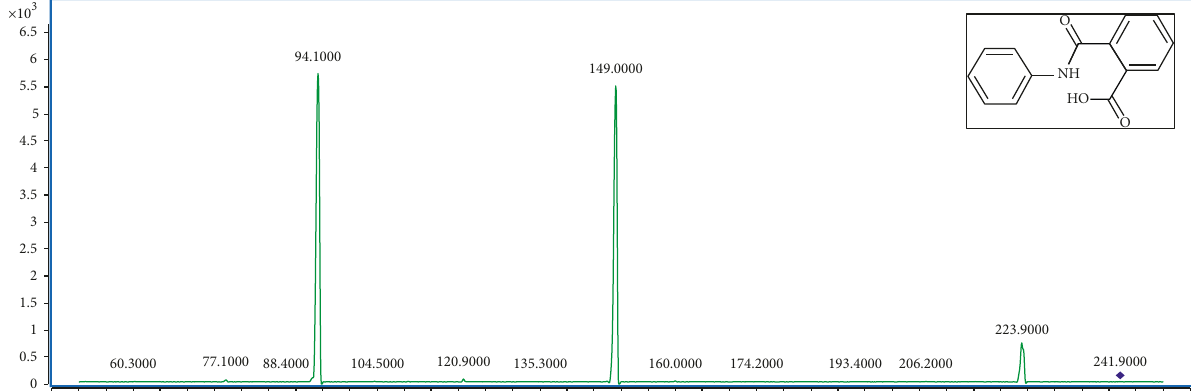
Figure 1: The chemical structure and secondary mass spectrum of phthalanilic